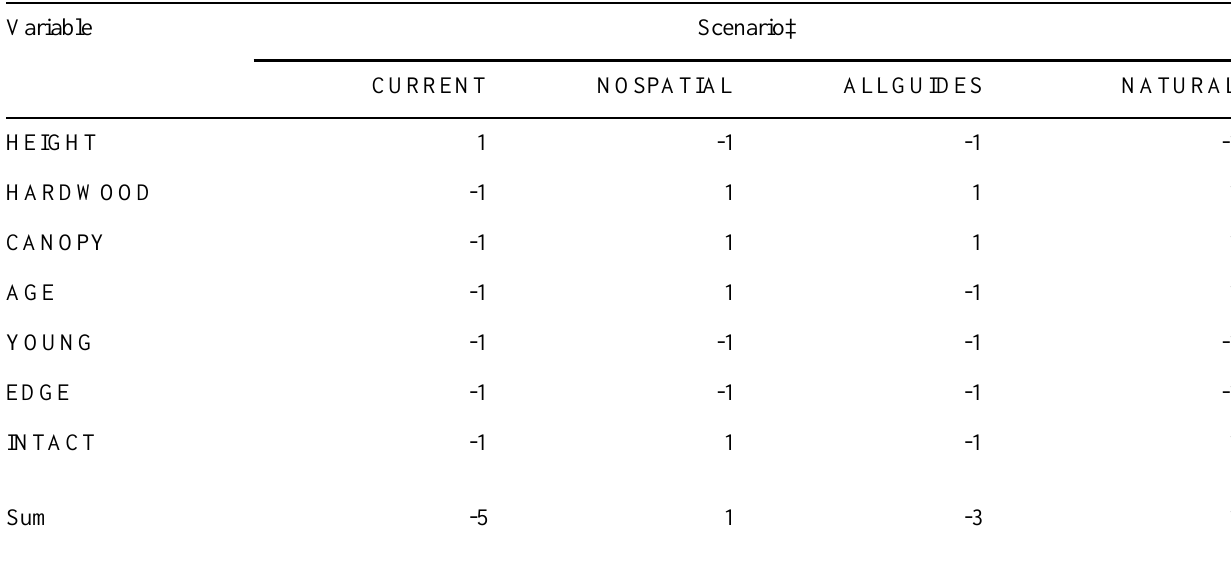
Table 4. Summary of forest response† relative to simulated range of natural variation (SRNV) for modeled variables at year 0 (CURRENT) and at year 100 (NOSPATIAL, ALLGUIDES, and NATURAL). Variable Scenario‡ CURRENT NOSPATIAL ALLGUIDES NATURAL HEIGHT 1 -1 -1 -1 HARDWOOD